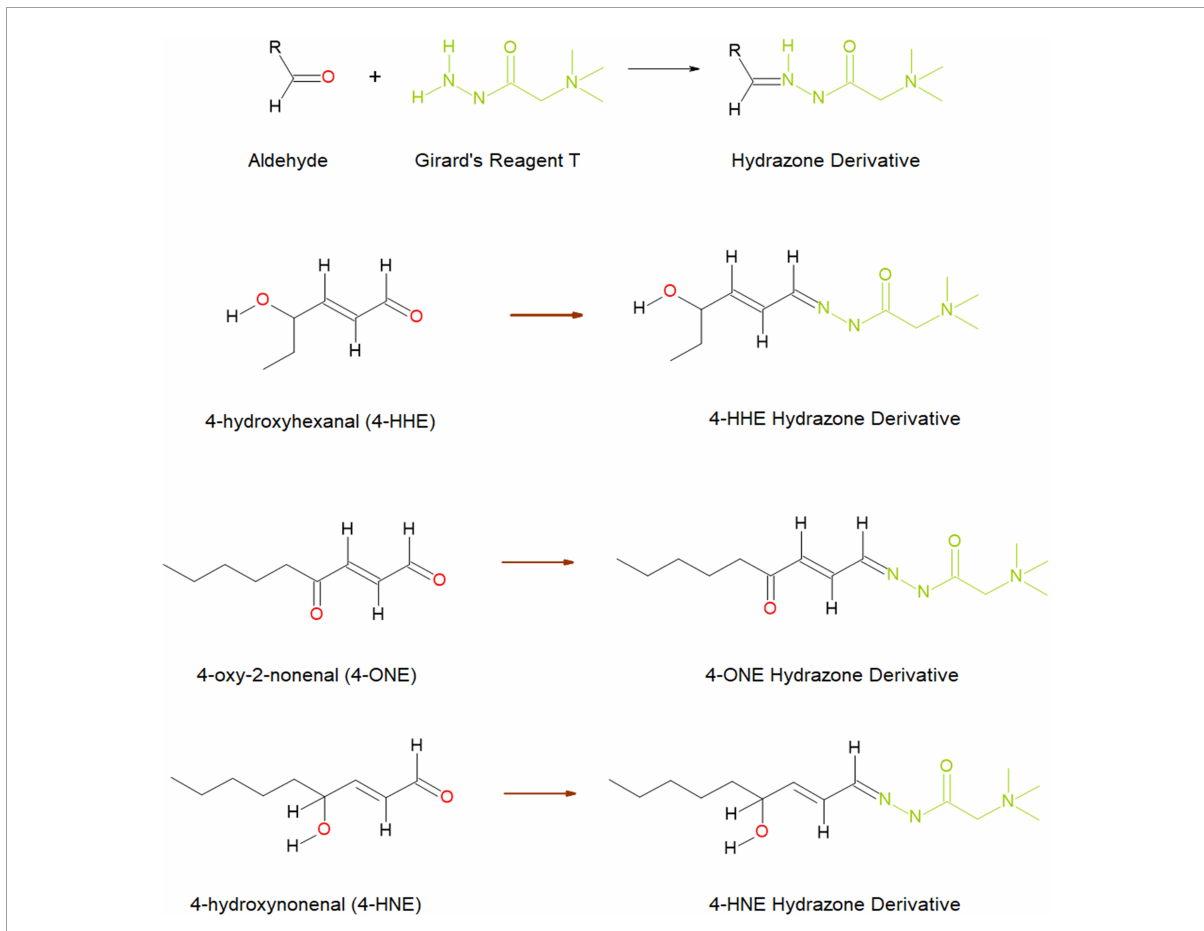
FIGURE1 Schematic diagram of the reaction between aldehydes and Girard’s reagent T forming hydrazone derivatives (top) , and the hydrazone formed through reaction with three reactive aldehydes; 4-hydroxyhexenal (4-HHE), 4-oxo-2-nonenal (4-ONE), and 4-hydroxynonenal (4-HNE) (below) . Image taken from Harkin, et al. (33) and reproduced under the Creative Commons License